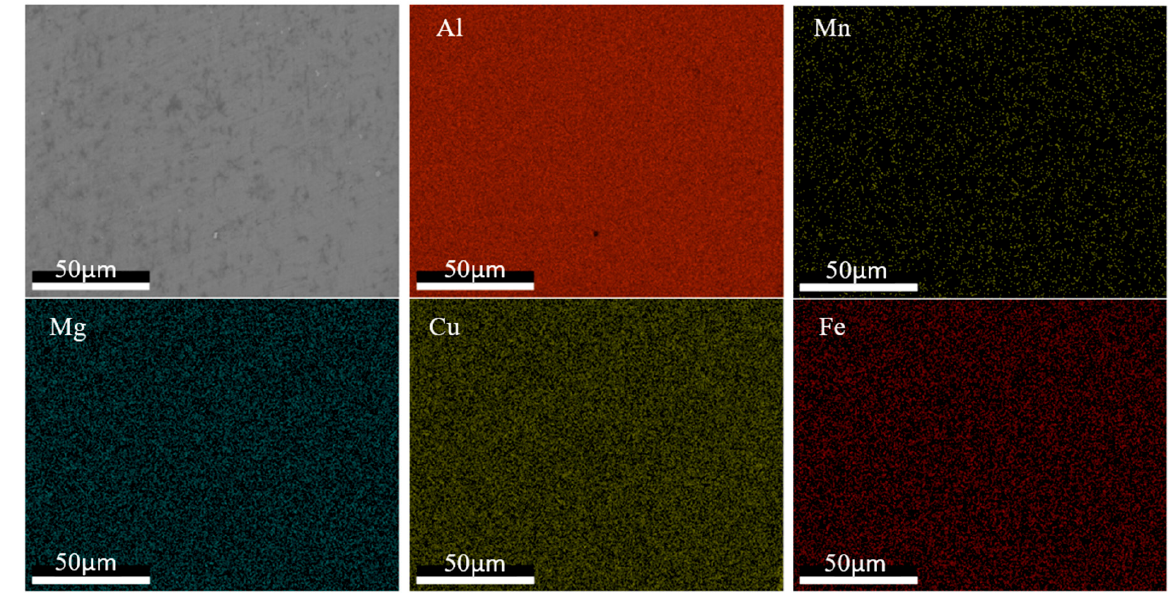
Figure 11. EDS mapping results showing the distribution of elements in the samples of the Al2050 feedstock material.